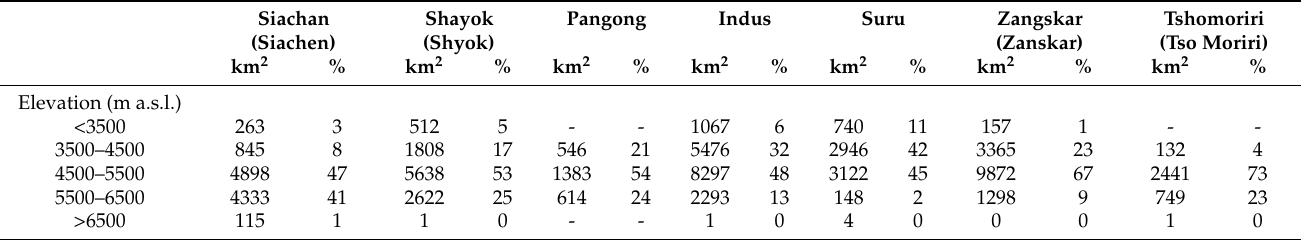
Figure 2. Topographical parameters (spatial resolution of 500 m) of the study area (75°32’E, 35°67’N to 79°46’E, 32°34’N): elevation ( left ), slope ( middle ), and aspect ( right ) (Table 1). Table 1. Spatial distribution of elevation, slope, and aspect in the seven subregions of